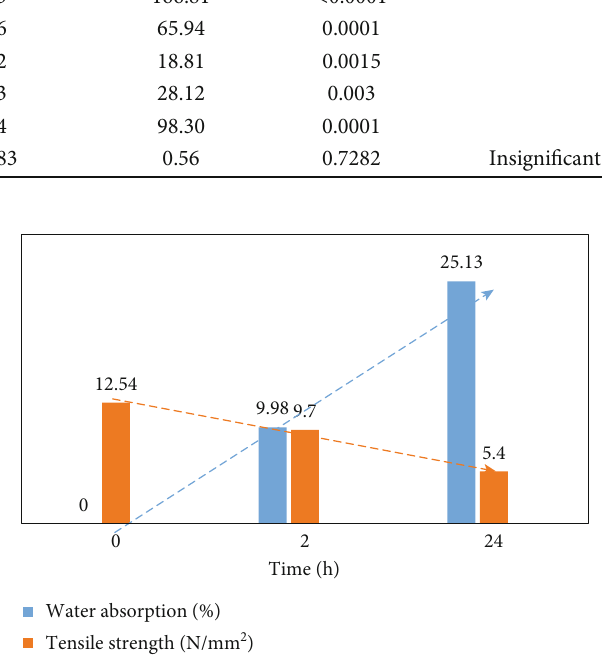
Figure 7: Water absorption test for 2 hours and 24 hours,